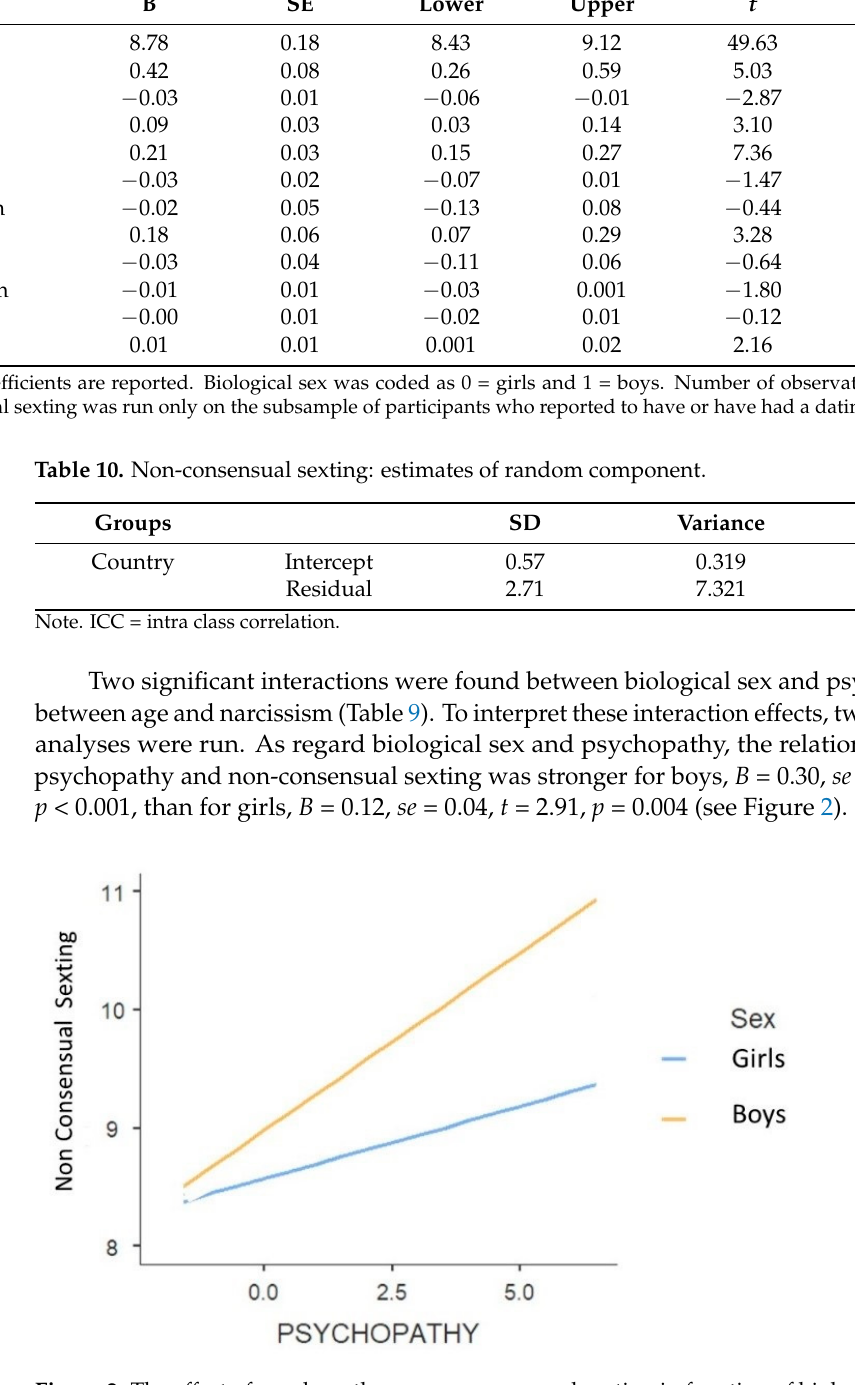
Table 9. Non-consensual sexting: parameter estimates of fixed effects.